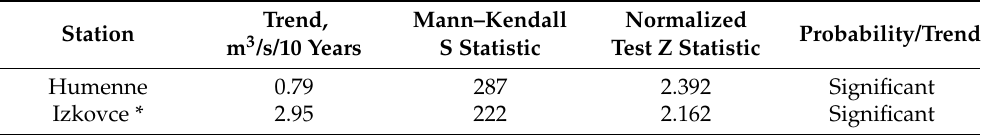
Table 4. Statistical characteristics of the hydrological data in the years 1970–2019. Station